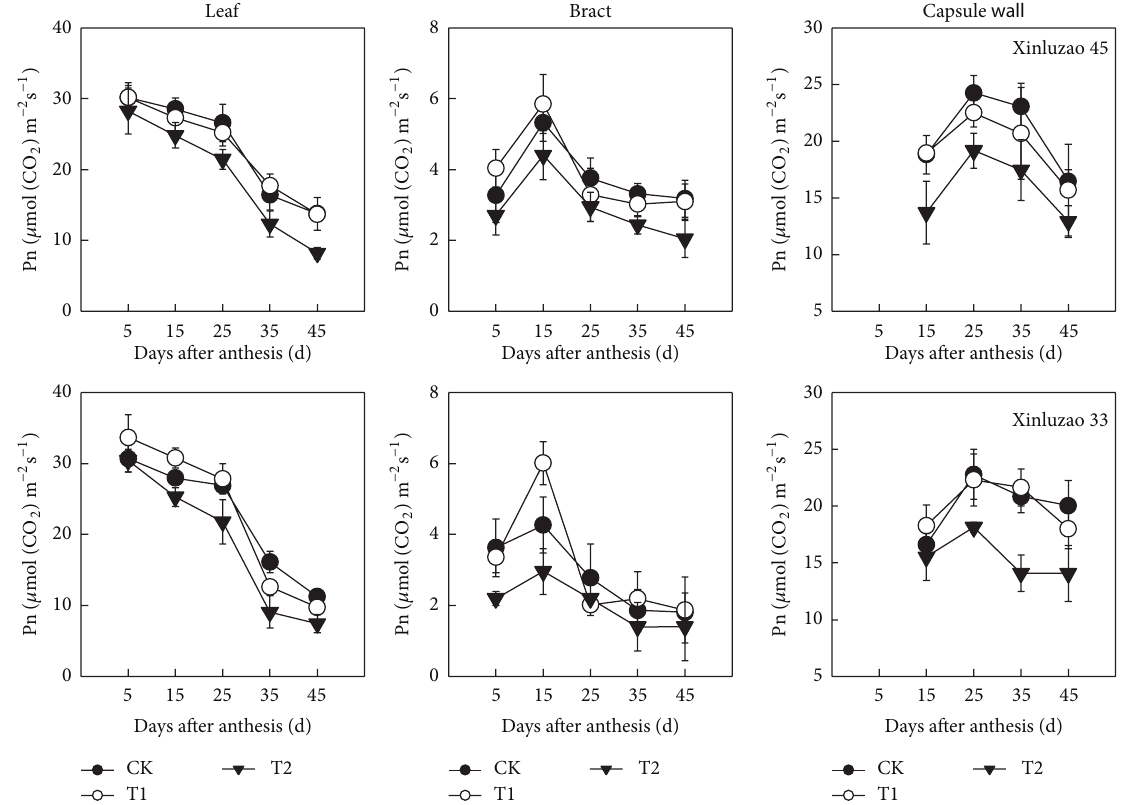
Figure 2: Temporal changes in the photosynthetic rates of leaves, bracts, and capsule walls in 2013. Values are means ± SD of four replicates. CK: conventional irrigation; T1: slight deficit irrigation; T2: moderate deficit irrigation. Table 3: Relative contributions of leaf and nonleaf organs to the total surface area of cotton plants grown under different irrigation treatments in 2012 and 2013. Cultivar